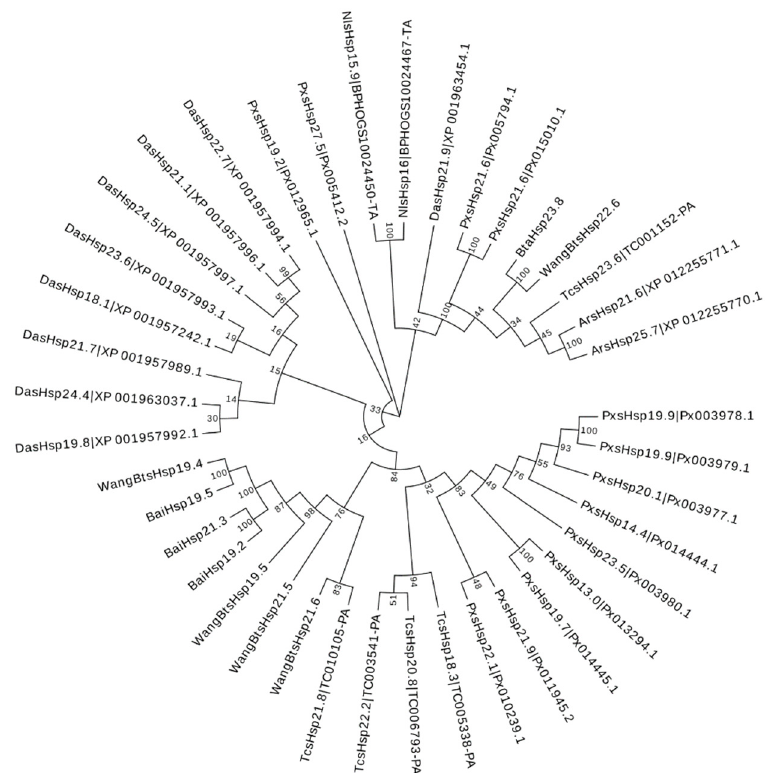
Figure 2. Phylogenetic relationships of sHsp s from Bemisia tabaci , Plutella xylostella , Tribolium castaneum , Drosophila ananassae , Athalia rosae , and Nilaparvata lugens . The unrooted phylogenetic tree was constructed using MEGA7 by the neighbor ‐ joining method and the bootstrap test was set as 1000 replicates. The colored shadow represents the different BtaHsp families.